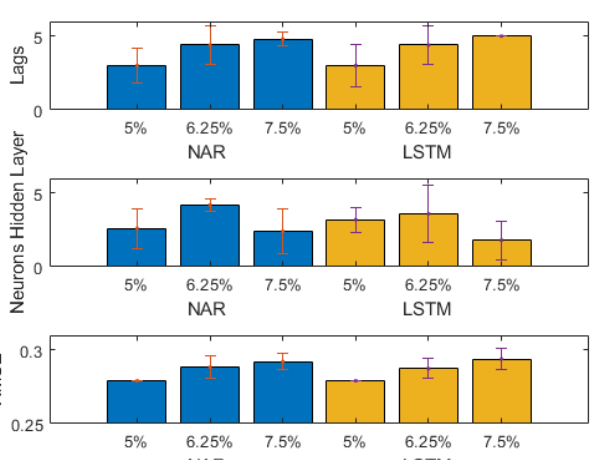
Figure 13. Resume of Results for the NAR and LSTM Models in the Simulation Cases when Noise was